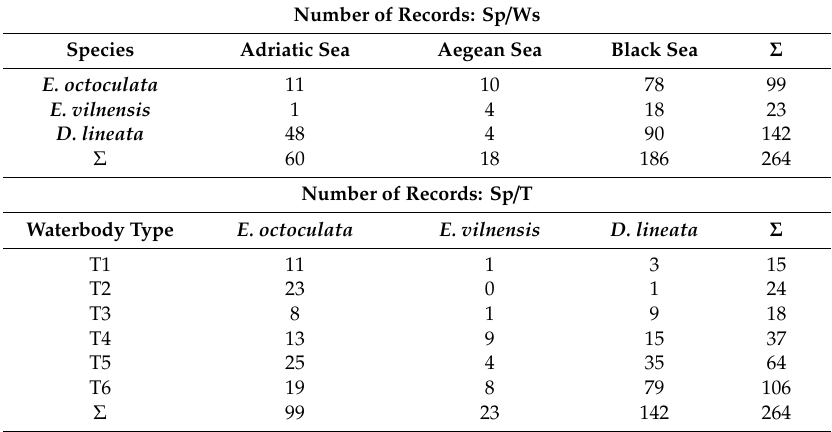
Table 3. The number of records (sampling sites) of each species per waterbody type and per